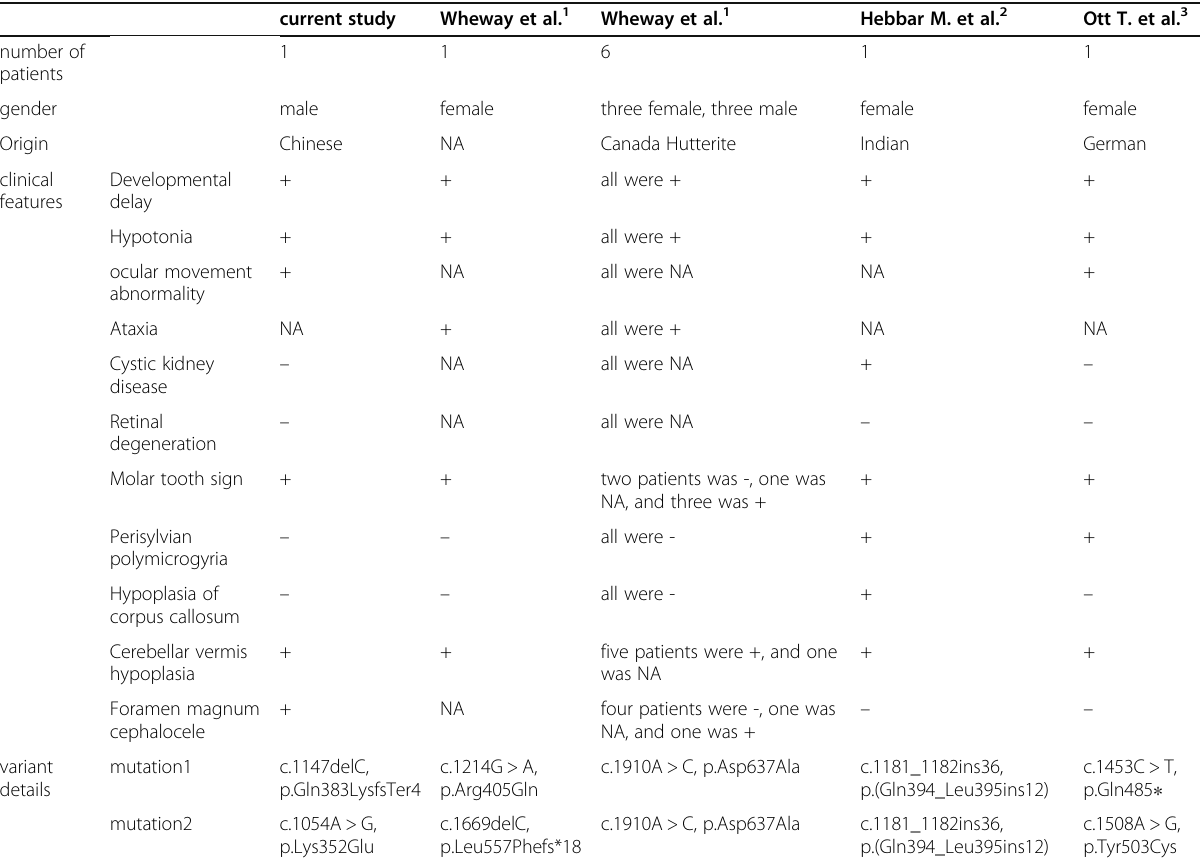
Table 1 Summary of clinical characteristics and PIBFI variants observed in Joubert syndrome patients